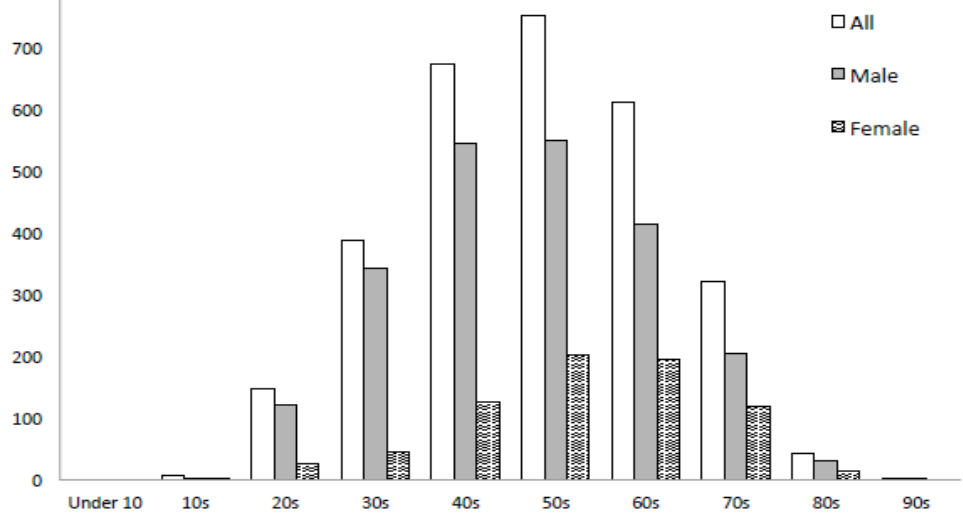
Figure 1. Age distribution of the patients. Table 2. Oral appliance type and evaluation methods.